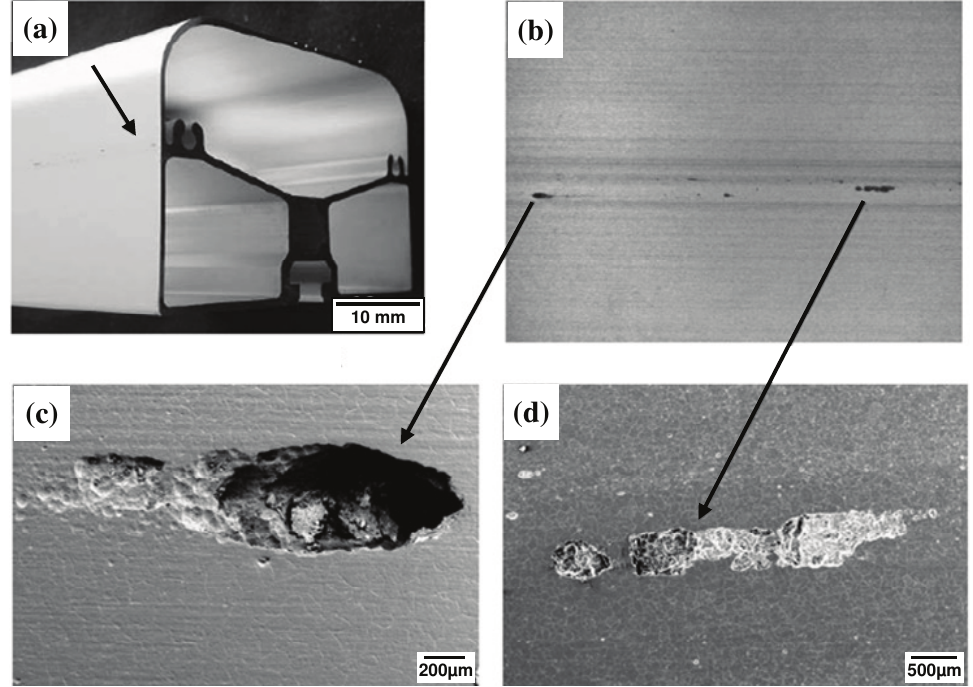
Figure 4. Streaks due to extrusion surface defects. (a) Profile of an anodized aluminium extrusion with streak defects, (b) surface morphology of the streaked region, and (c) and (d) remains of etching pits in the anodized